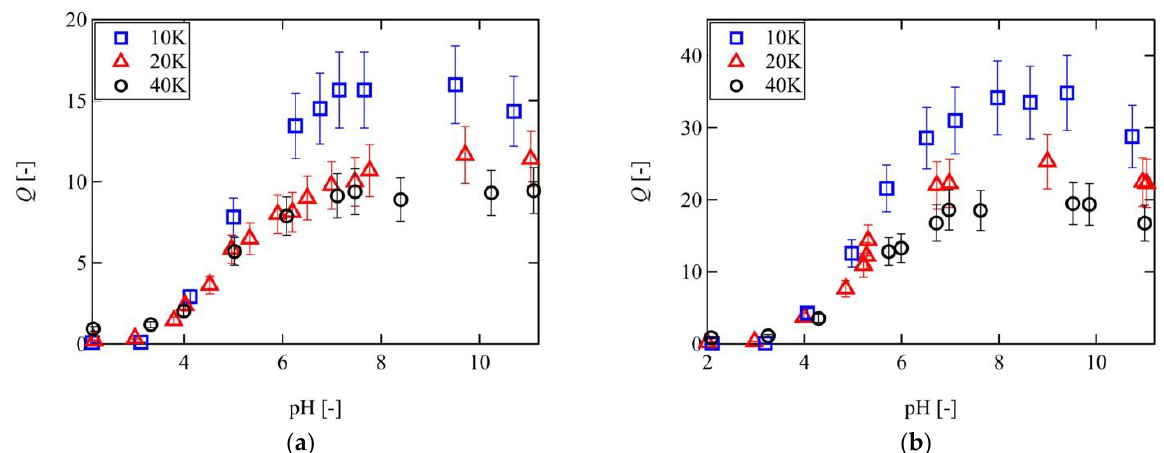
Figure 3. pH dependence of the swelling ratios of the 10 K (blue), 20 K (red), and 40 K (black) Tetra-PAA-PEG gels in salt solutions with different ionic strengths. ( a ) 10 mM, ( b ) 2 mM.